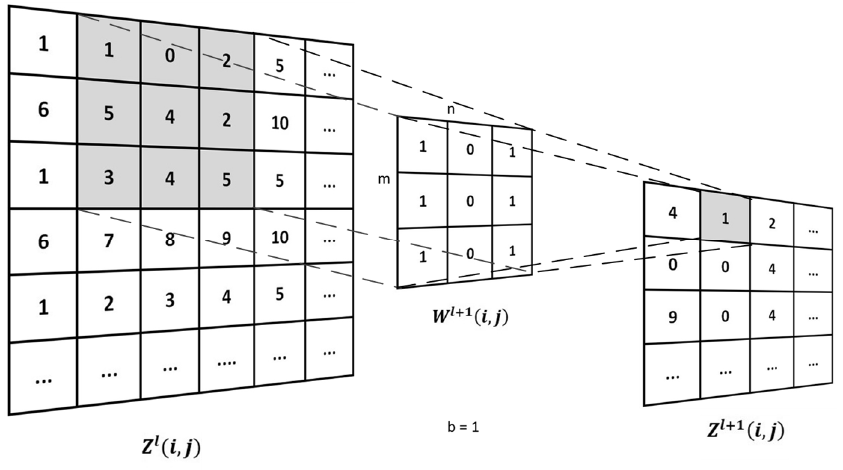
Figure 5. Convolutional operation.